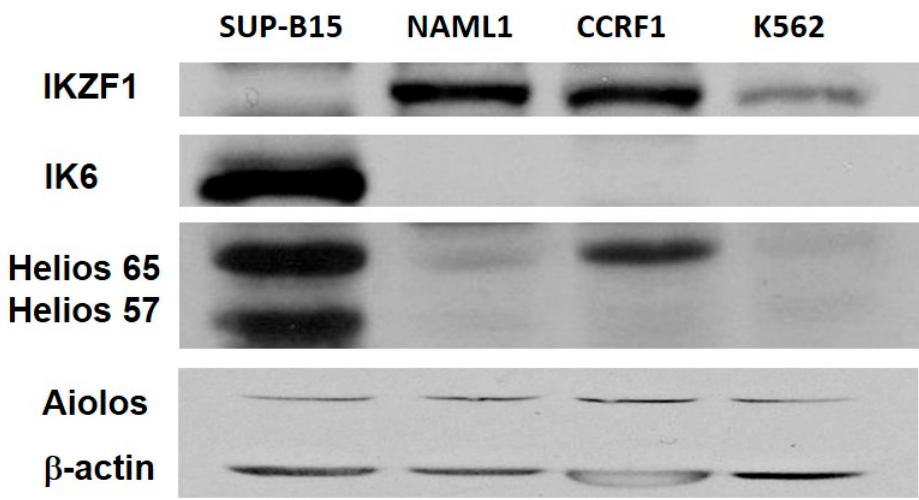
Figure 3. Detection of IKZF1 and IKZF family proteins in leukemic cell lines. Western blot analysis of four leukemia cell lines for IKZF1 full protein (top), Ik-6 (2nd from top), both with an anti-IKZF1 antibody, as well as Helios (anti-IKZF2 antibody), Aiolos (anti-IKZF3 antibody), and β -actin. The expected sizes of the proteins are IKZF1: 57.5 kDa, Ik-6: 38.2 kDa, Helios/IKZF2: 65 and 57 kDa, Aiolos/IKZF3: 70 kDa, and β -actin: 42 kDa (Figure S1).